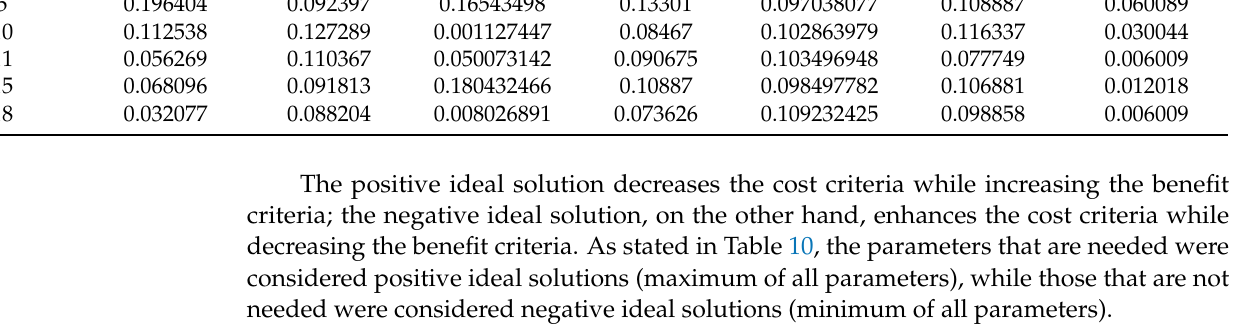
Table 10. Positive and negative ideal solutions.